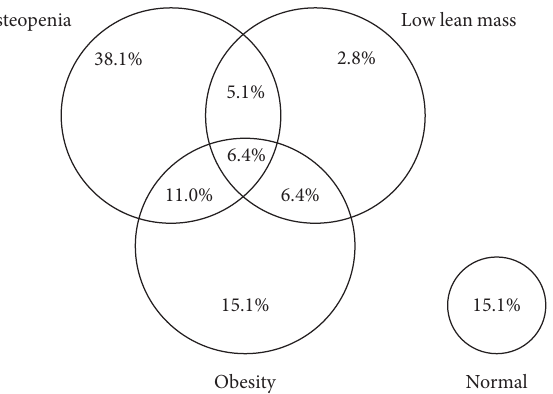
Figure 2: Venn diagram of overlap of the frequencies of osteopenia, low lean mass, and obesity in the study population. “Normal” circle represents those without disturbances in body